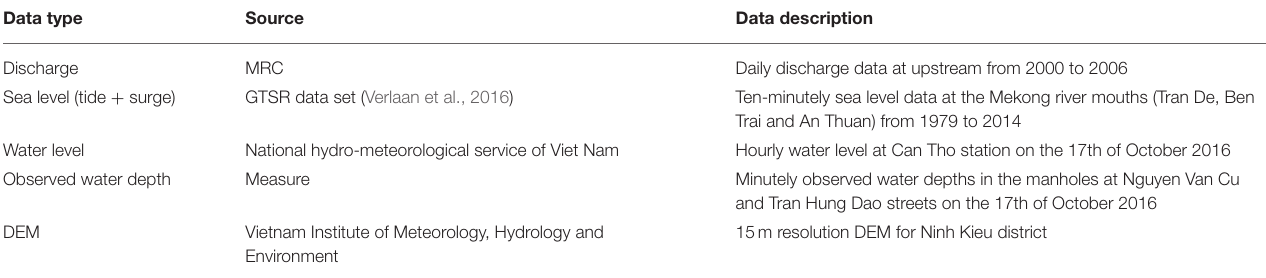
TABLE 1 | Data source used in this